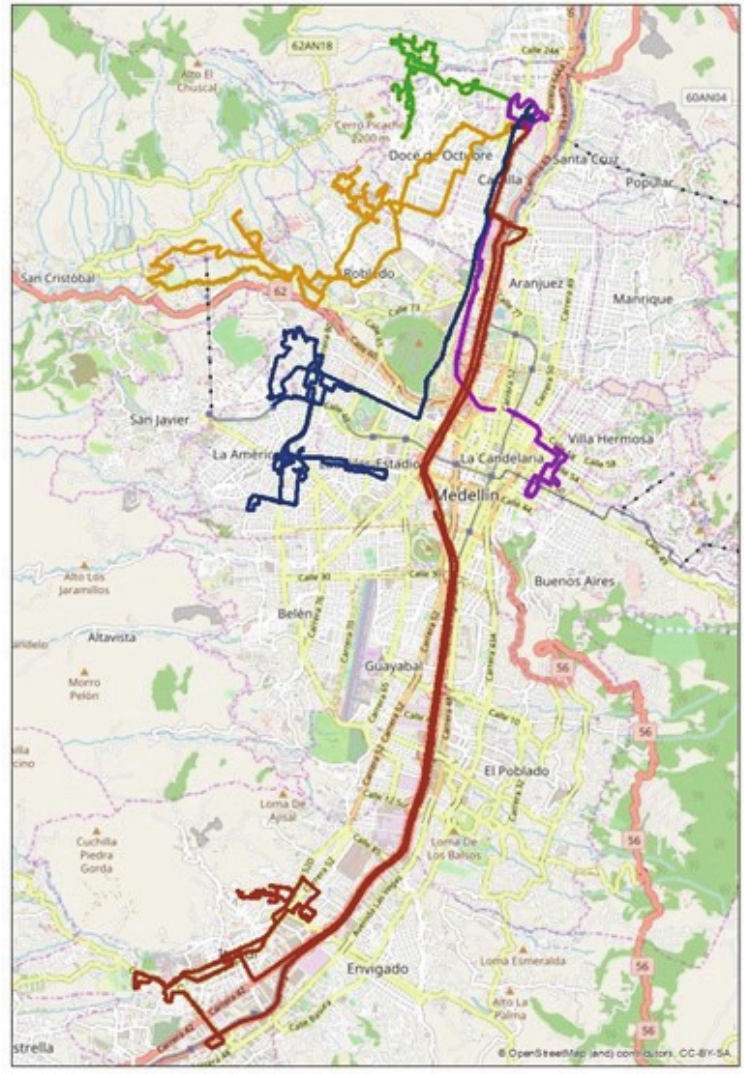
Figure 1. Tours made with GPS: Route 1 (Blue) (La América and San Javier), Route 2 (Red) (Itagüí city), Route 3 (Purple) (Downtown), Route 4 (Orange) (October 12 and Robledo) and route 5 (Green) (Castilla).